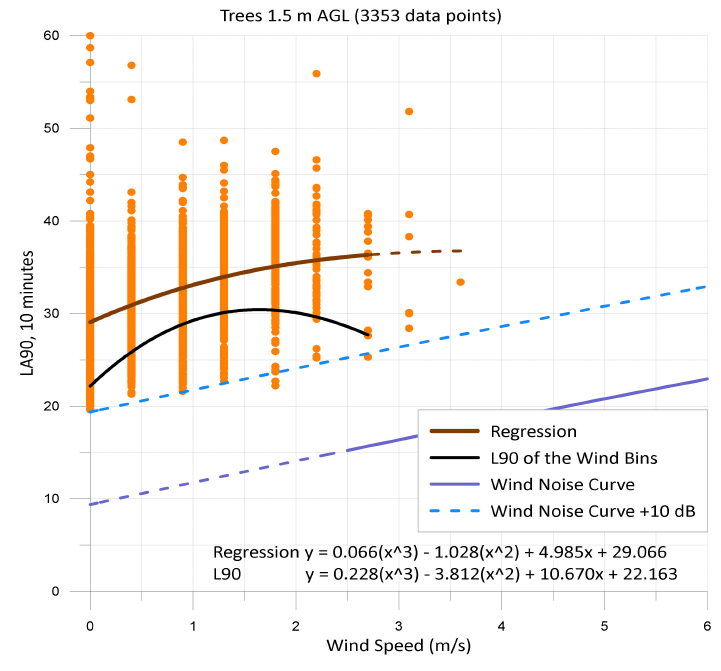
Figure 11. Ambient Regression Line—wind and noise at 1.5 m AGL10 from